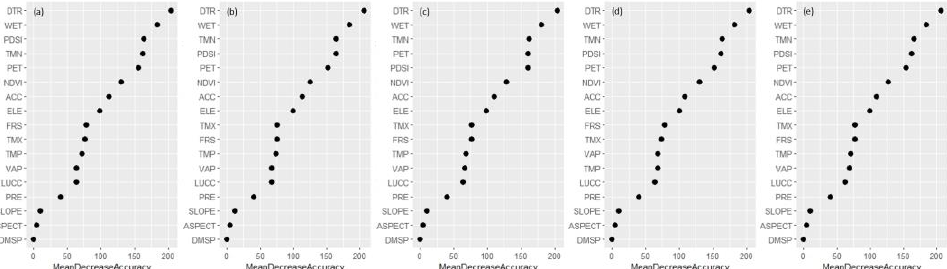
Figure 3. Variable importance measure from RF five sub-samples ( a – e ) based on mean decrease accuracy (x-axis). Variable names are also found in Table